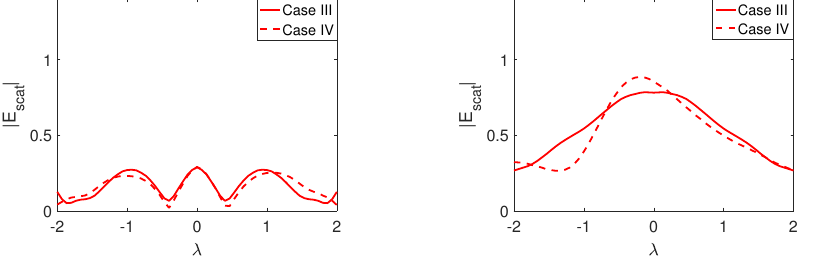
Figure 14. ( a , b ) normalized magnitude of the incident NF at the receiver line; ( c – f ) scattered NF at the receiver line for Configurations I and II regarding Case I (single small box), Case II (elongated box consisting of an OI and two undesired scatterers), Case III, (single small cylinder) and Case IV (small cylinder with an offset extra undesired scatterer) respectively. In Configuration I, these fields correspond to the ˆ y component of the electric field, and, in Configuration II, they correspond to the ˆ x component of the electric